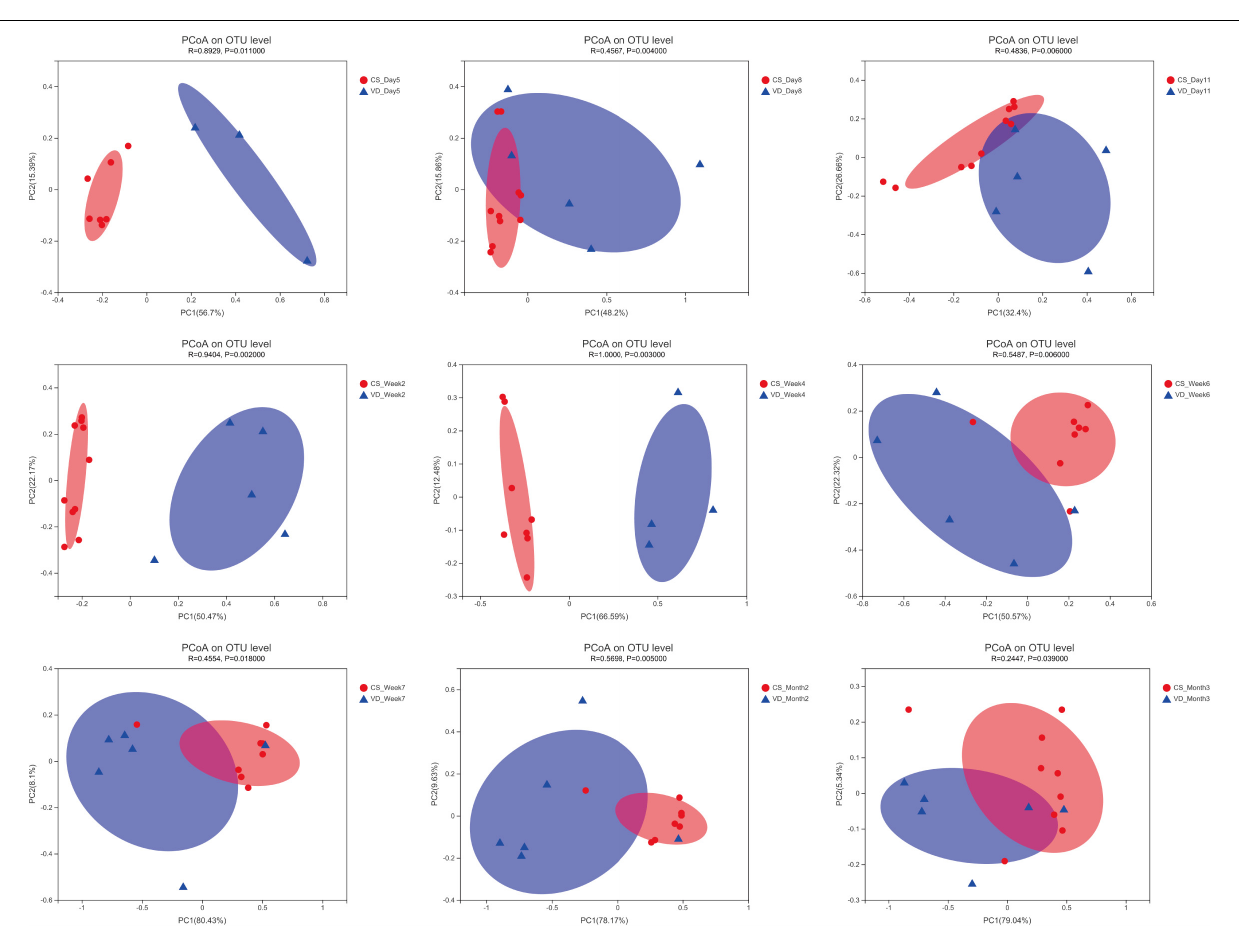
Frontiers in Microbiology |